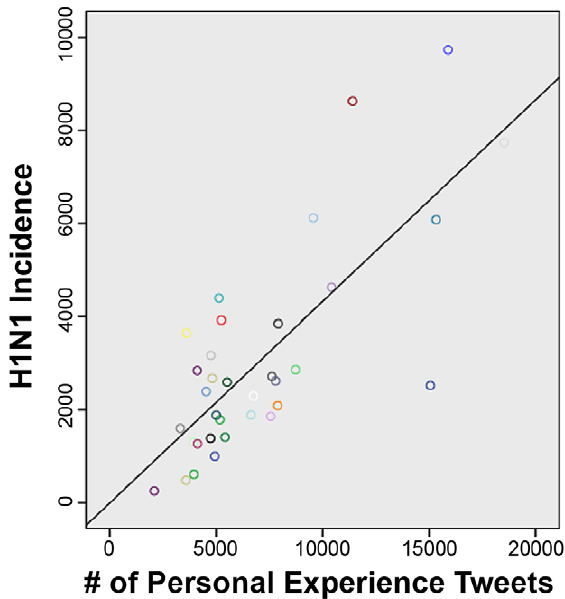
Figure 4. Scatterplot of tweets sharing personal experiences and USA H1N1 incidence rate.